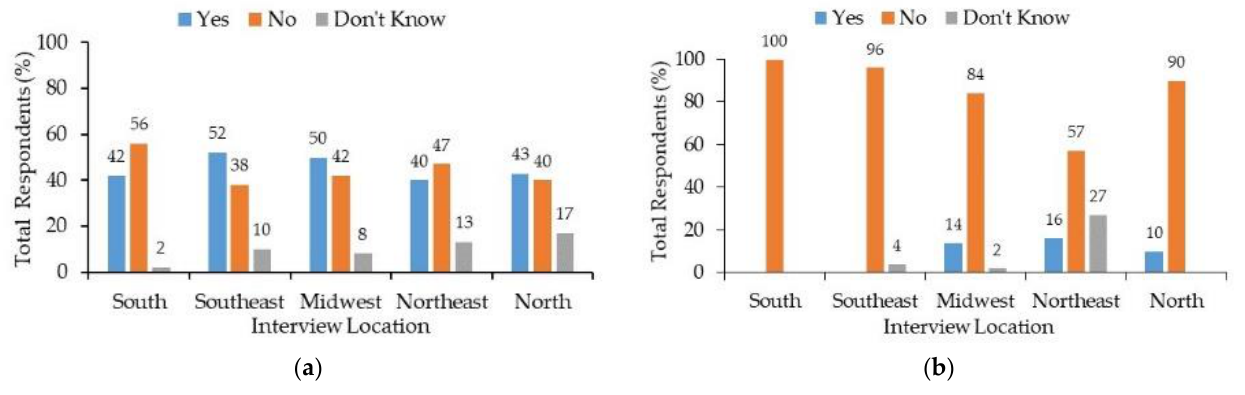
Figure 2. Perception about the existence of negative impacts ( a ), perception about monitoring the implementation of wind farms by an environmental agency ( b ), according to the total number of interviewees by region. Source: elaborated by the author.